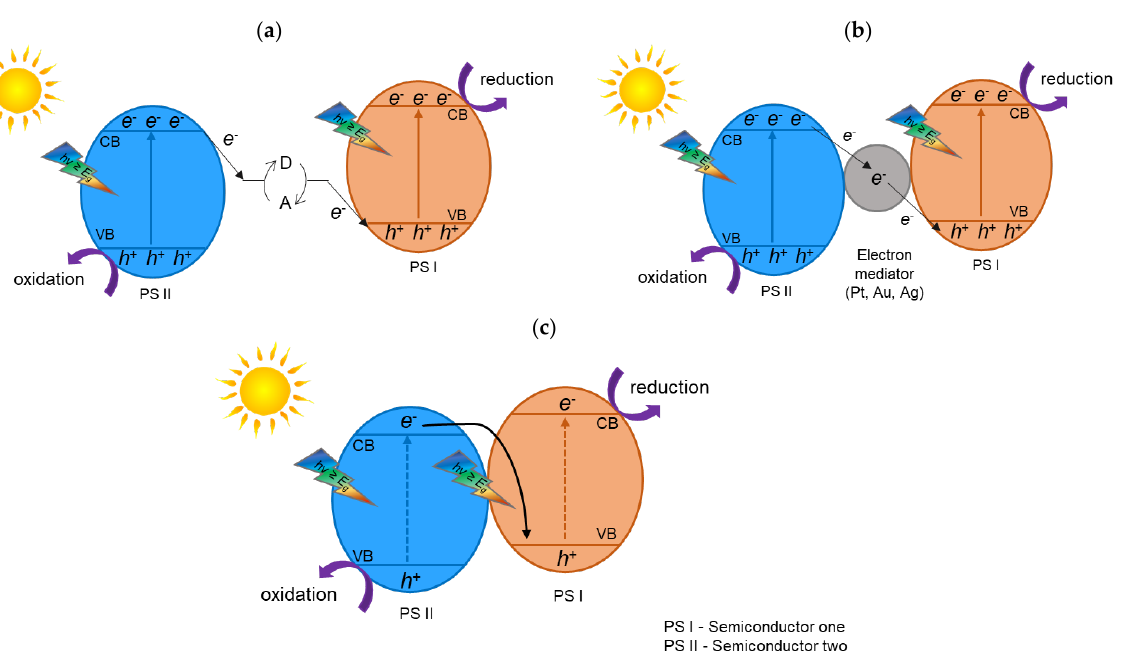
Figure 4. Schematic representation of ( a ) electron – hole separation on the conventional Z-scheme photocatalytic system; ( b ) the electron – hole separation on all-solid-state Z-scheme photocatalysts; photocatalytic system; ( b ) the electron–hole separation on all-solid-state Z-scheme photocatalysts; and ( c ) electron – hole separation on a direct Z-scheme heterojunction photocatalyst. Adapted ac- and ( c ) electron–hole separation on a direct Z-scheme heterojunction photocatalyst. Adapted accord- cording to Refs. [18,19]. ing to Refs.